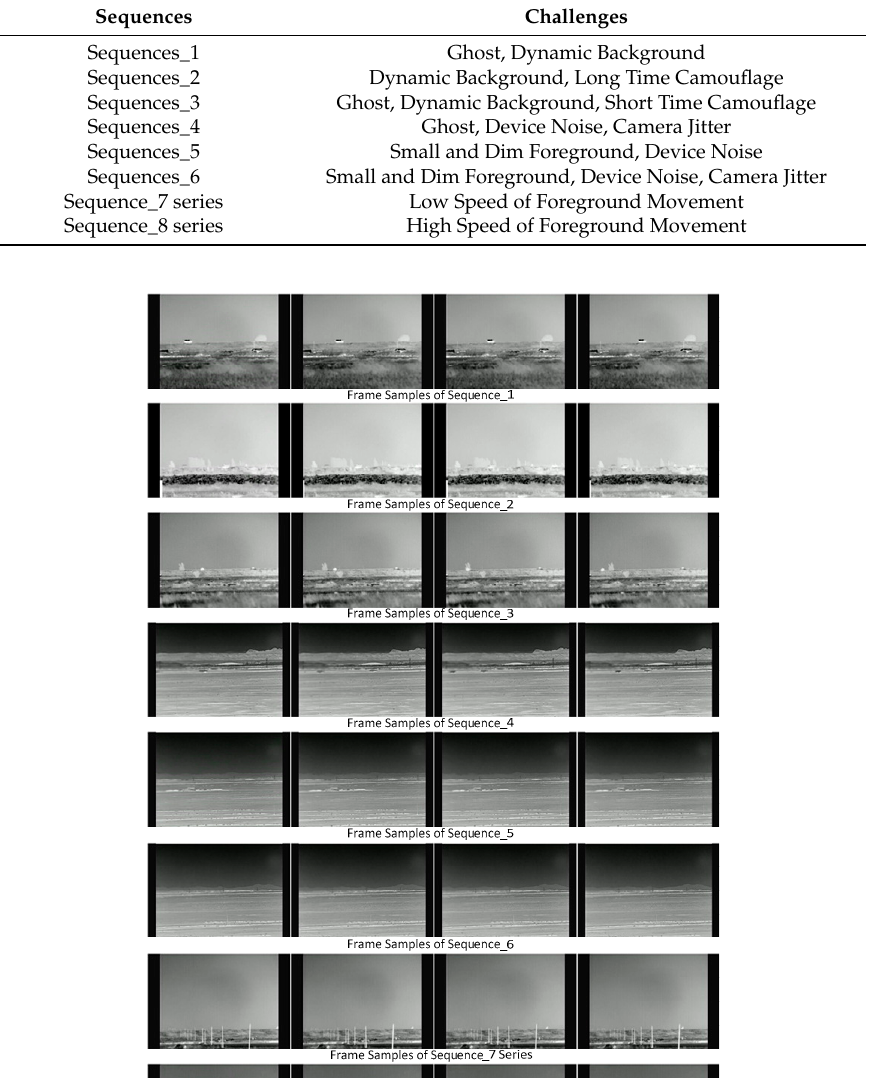
Table 5. Challenges represented in each video sequence of the Remote Scene IR Dataset. Table 4. Challenges represented in each video sequence of the Remote Scene IR Dataset.